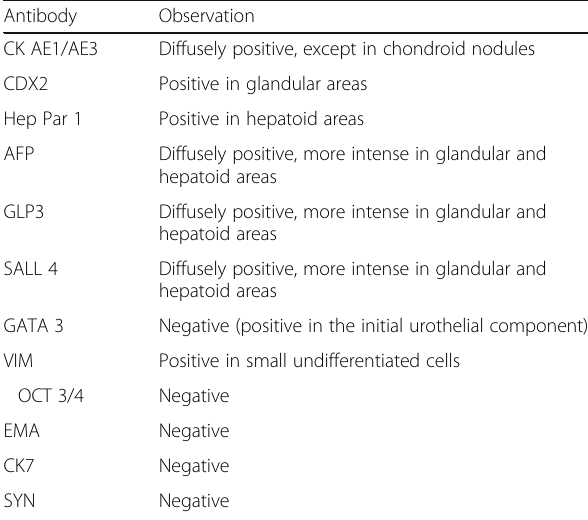
Table 1 RESULTS OF